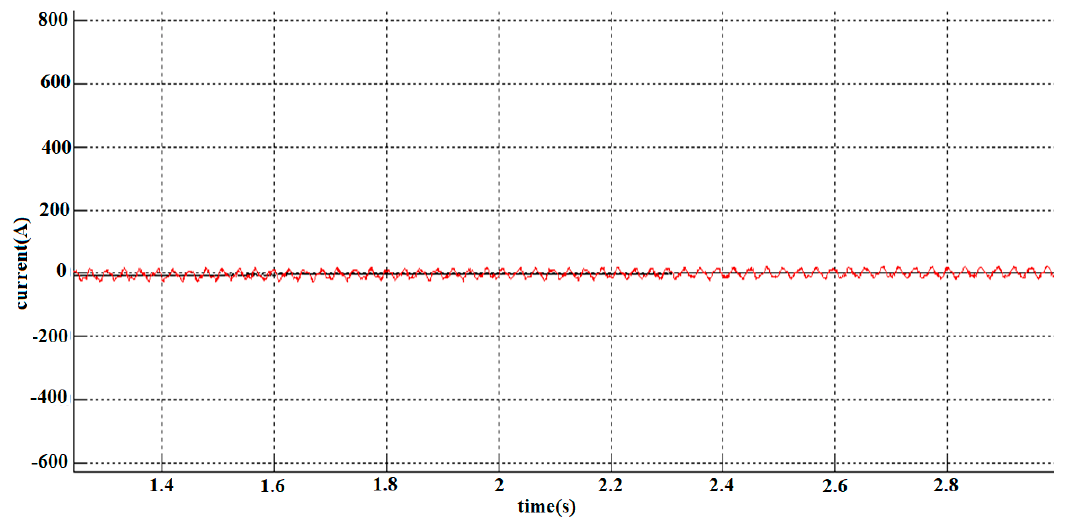
Figure 18. Output-side q axis current.